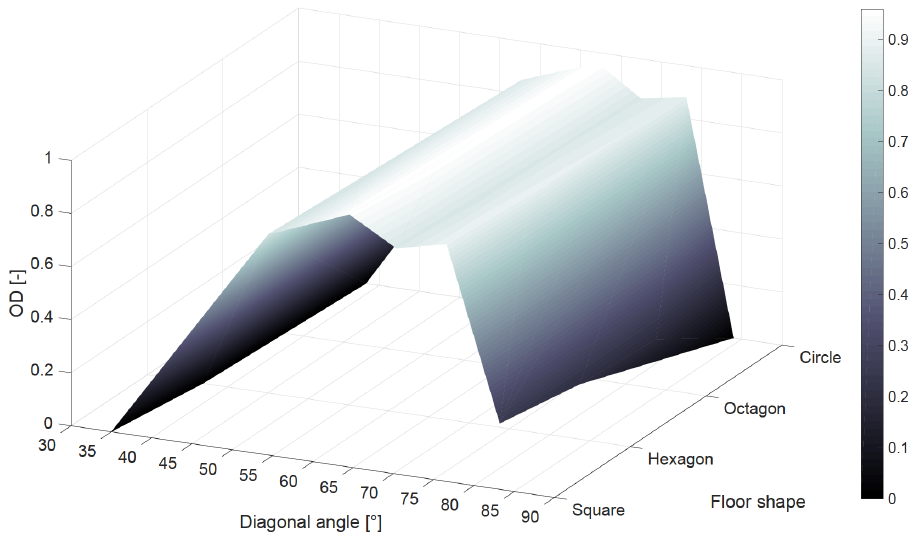
Figure 3: Surface representation of the OD with respect to the diagrid geometrical parameters (diagonal angle and floor shape). OD values are reported in the vertical axis and represented by means of color shades